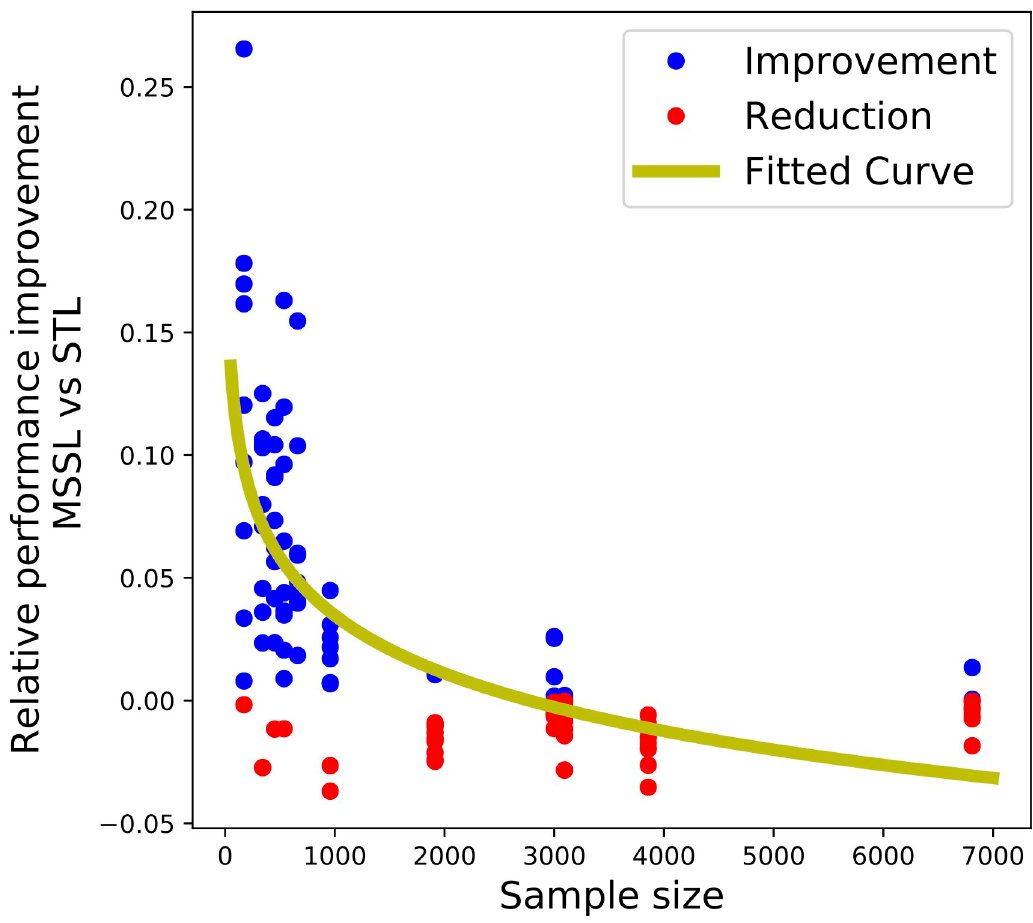
Fig 8. Correlation between task training sample size and MSSL relative performance improvement over STL. Tasks split by Topography group 1 . MSSL shows higher improvement over STL particularly for tasks with smaller sample